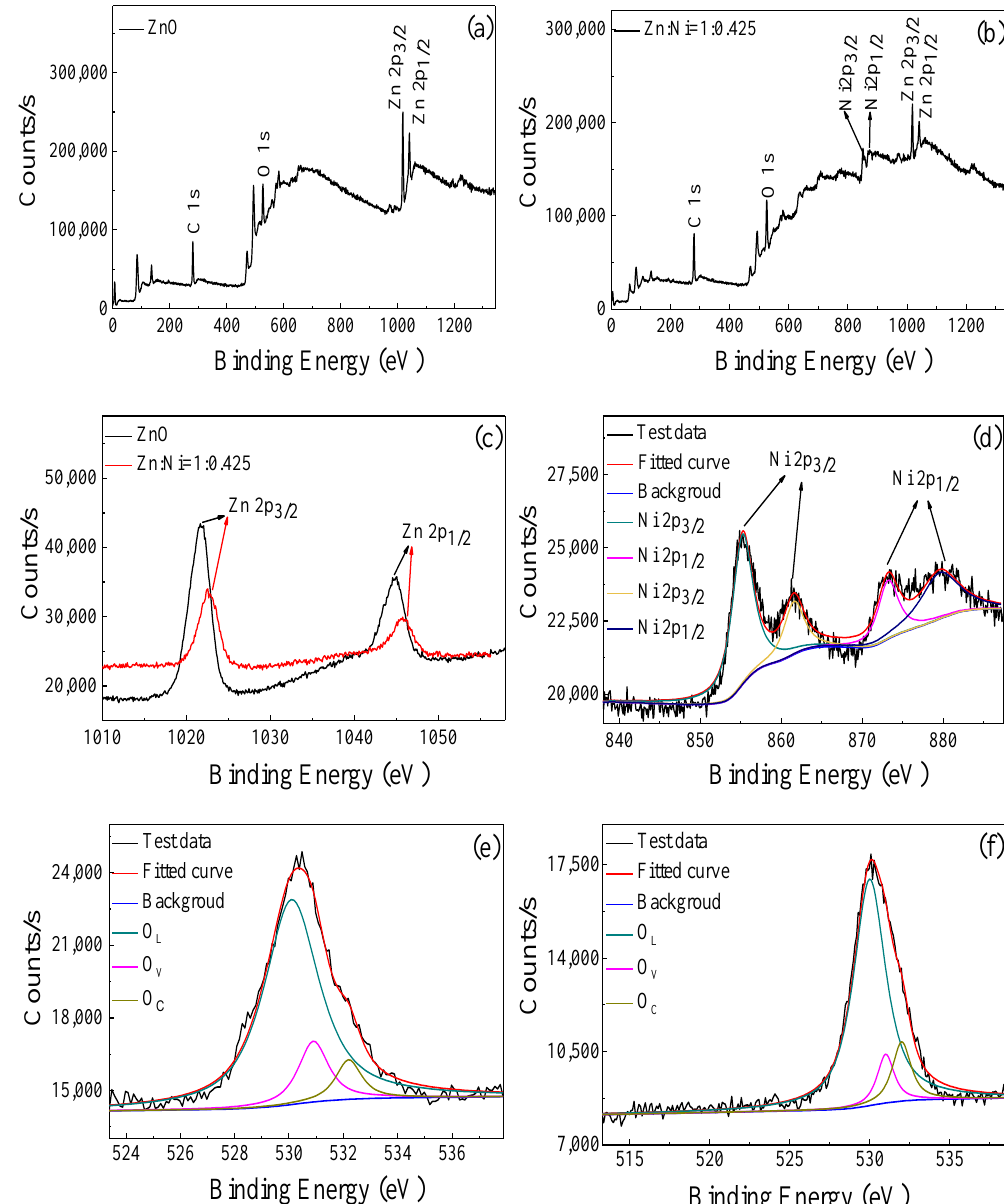
Figure 4. XPS survey spectra of ZnO and ZnO–0.425NiO annealed at 550 ◦ C: ( a ) full spectra of ZnO, ( b ) full spectra of ZnO–0.425NiO, ( c ) Zn 2p spectra of ZnO and ZnO–0.425NiO, ( d ) Ni 2p spectra of ZnO–0.425NiO, ( e ) O 1s spectra of ZnO, ( f ) O 1s spectra of